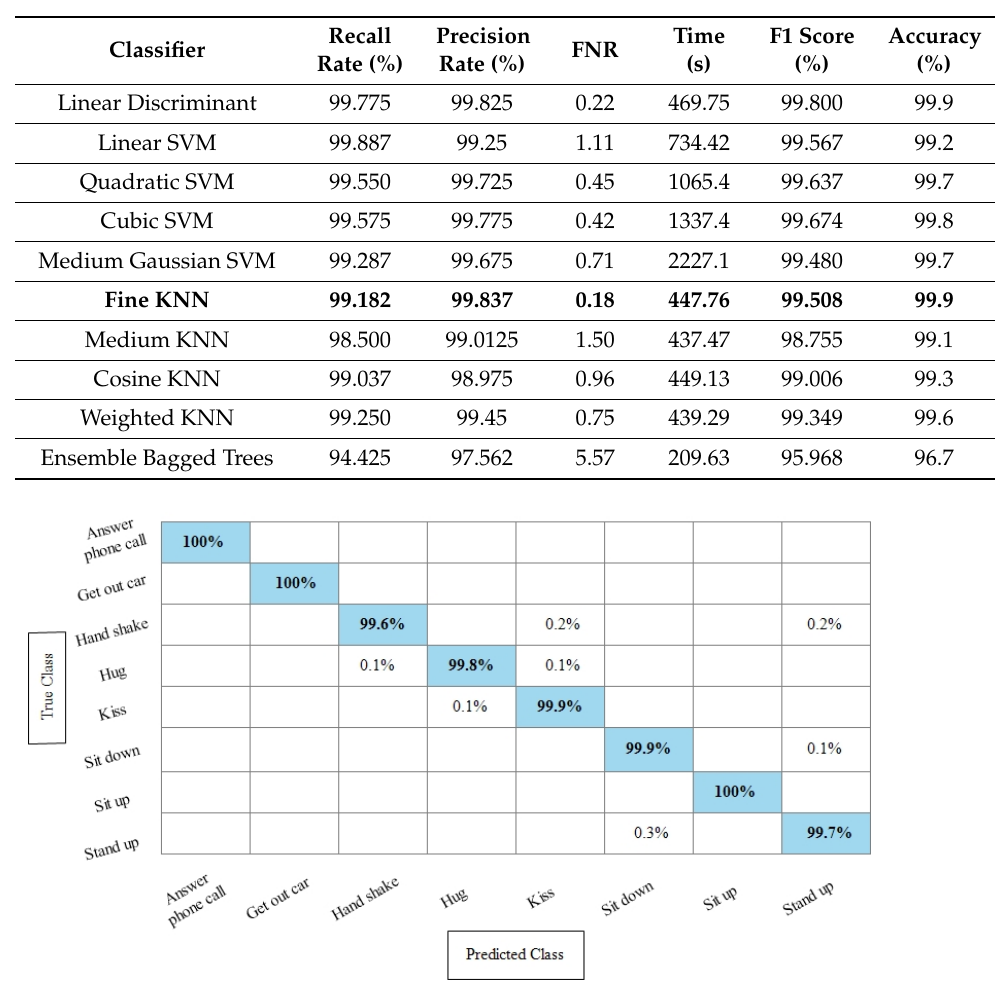
Figure 10. TPR-based confusion matrix of Linear Discriminant classifier after fusion of deep fea- tures using SbE approach.